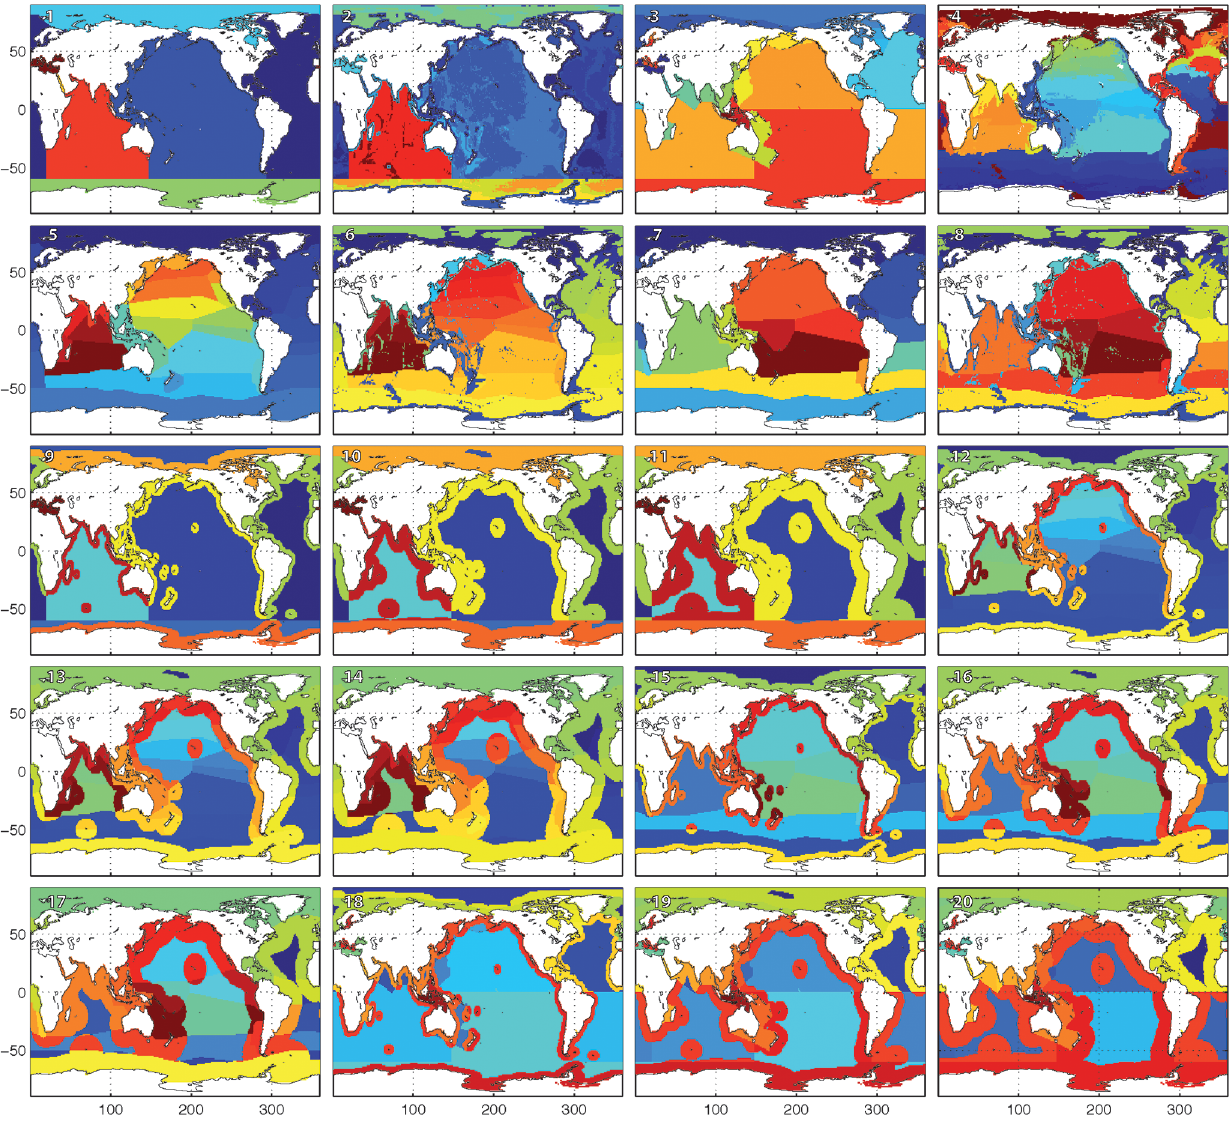
Figure A1. Province maps used in this study; see details in the text. 1. ocean; 2. carbonate saturation; 3. seas; 4. Longhurst; 5. simplified Longhurst 1 (S.L.1). 6. S.L.1 plus depth; 7. S.L.2; 8. S.L.2 plus depth; 9. ocean 500km; 10. ocean 1000km; 11. ocean 1500km; 12. S.L.1 500km; 13. S.L.1 1000km; 14. S.L.1 1500km; 15. S.L.2 500km; 16. S.L.2 1000km; 17. S.L.2 1500km; 18. seas 500km; 19. seas 1000km; 20. seas